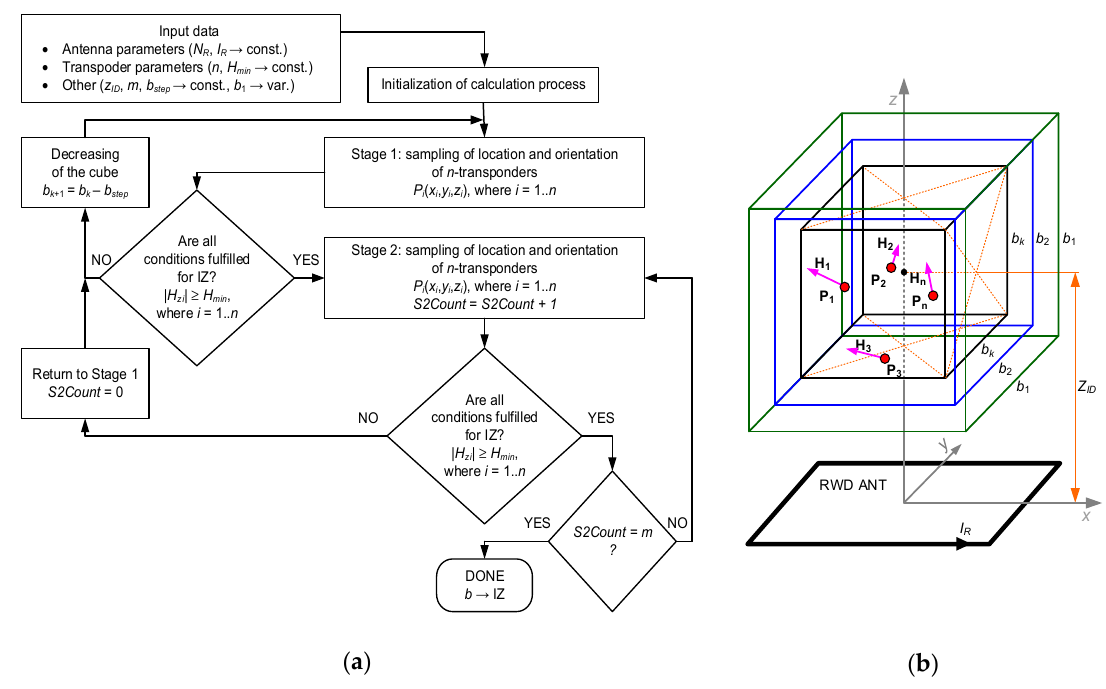
Figure 25. Procedure of 3D IZ determination: ( a ) Algorithm; ( b ) model of IZ.